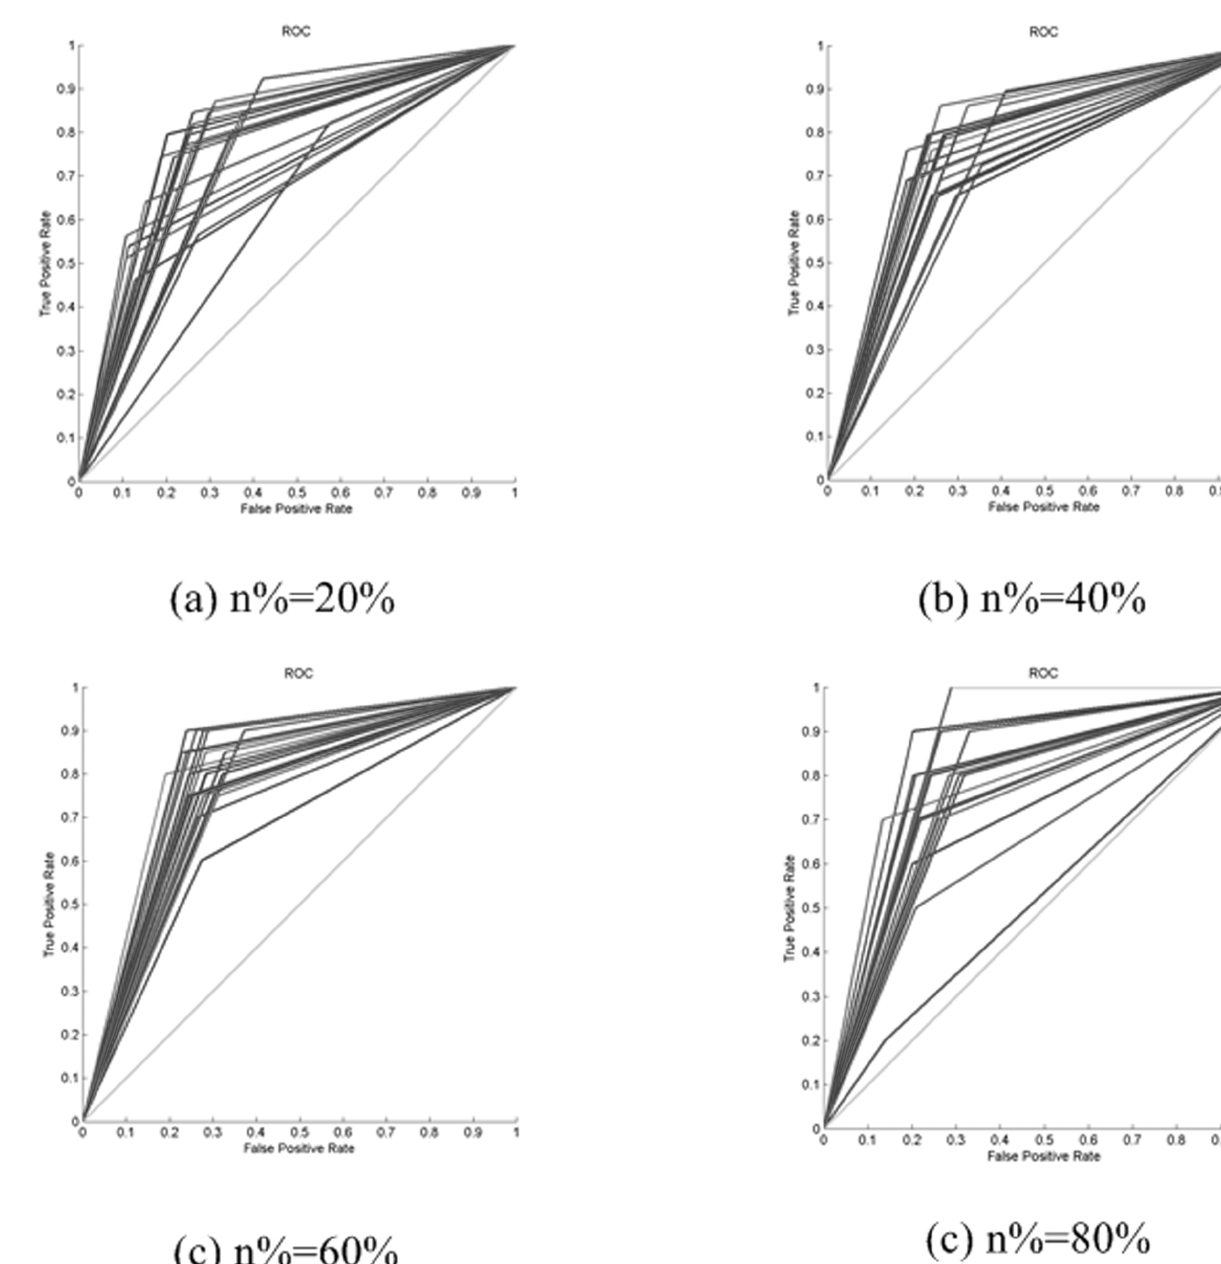
Figure 6. The ROC of a class obtained from the MIHC learning system by MLSVM for the cdc28 dataset. The ROC curves of the 20 repetitions of the experiment as well as the four subplots (a), (b), (c), and (d) with parameter n%=20%, 40%, 60%, and 80%, respectively, are shown.